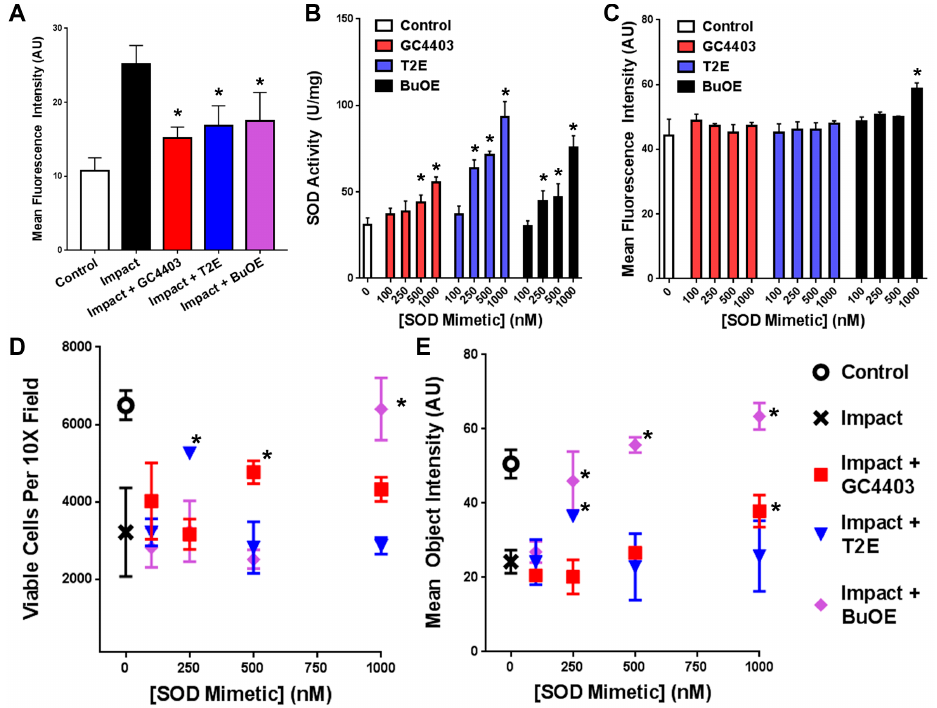
Figure 2. GC4403, T2E, and BuOE provide dose-dependent protection of chondrocytes 24 h after 2 J impacts. ( A ) Previously described [21] increases in DHE staining of chondrocytes within 10 × objective confocal images of impacted sites were reproduced and this increase was blunted with treatment by all three mimetics ( n = 3). ( B ) SOD activity in unloaded primary chondrocytes shows a dose responsive increase with all three SOD mimetics ( n = 3). ( C ) Mitochondrial staining with MitoTracker Deep Red following mimetic treatments in the absence of loading shows minimal changes in mitochondrial staining with the exception of the 1000 nM dose of BuOE, though many other mimetic treated samples insignificantly trended towards stronger staining than control ( n = 3). ( D ) Cell counts of Calcein Green AM positive cells from 10 × objective confocal images of sites within the impact zone ( n = 3) show maximal protection by GC4403 between 500 nM and 1000 nM, protection by T2E at 250 nM, and protection by BuOE at 1000 nM. ( E ) Mean intensities of MitoTracker Deep Red from cells in ( A ) show maximal benefit from GC4403 at 1000 nM, protection by T2E at 250 nM, and protection by BuOE peaking at 1000 nM ( n = 3). * indicate p < 0.01 compared to impact tissue without treatment and include both the T2E and BuOE treatments at 250 nM in panel